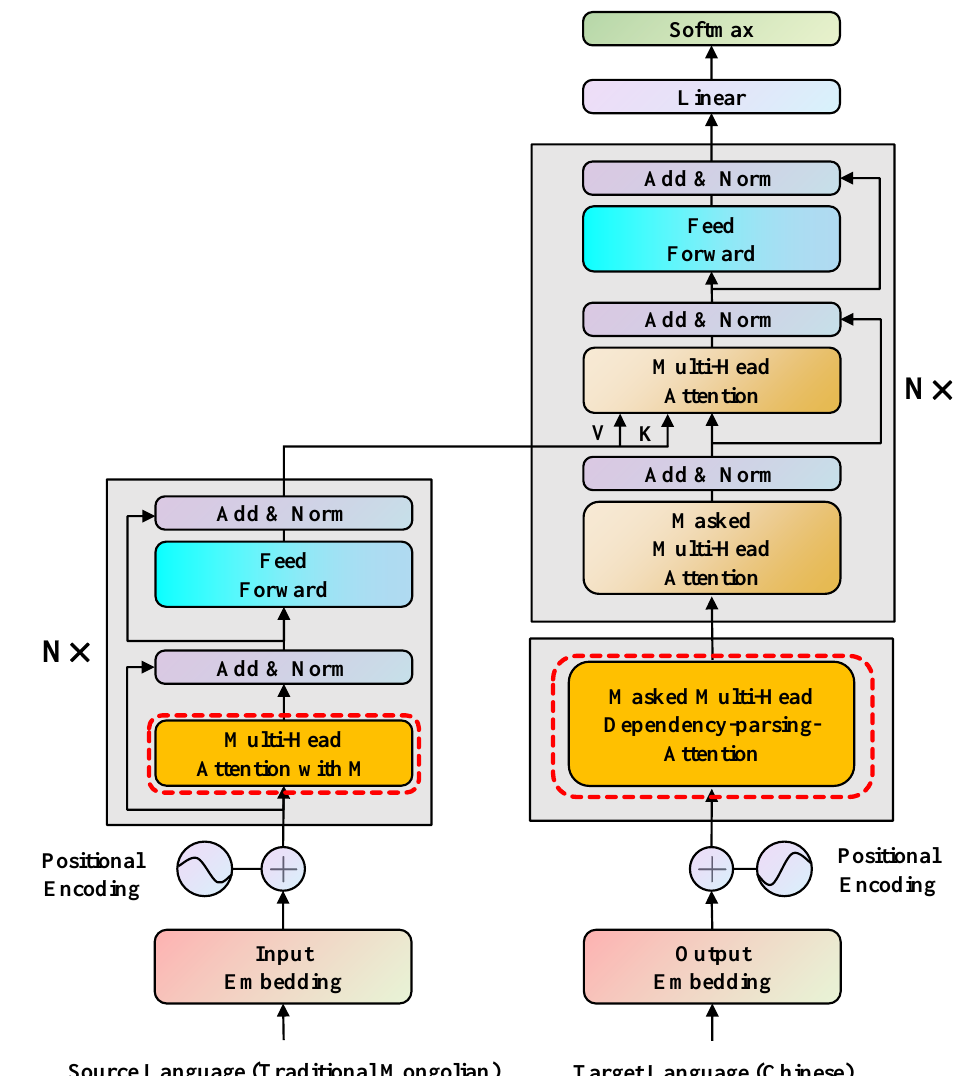
Figure 2. The structure of the proposed